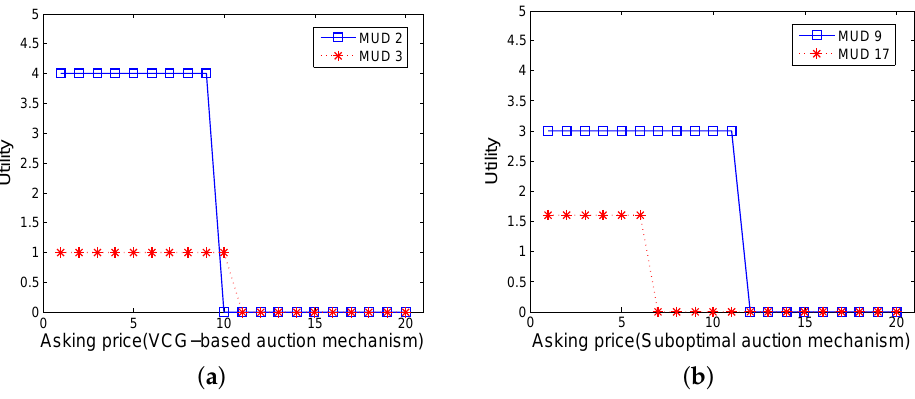
Figure 5. ( a ) The utility of MUD 2 and MUD 3 by VCG-based auction mechanism in continuous working case; ( b ) The utility of MUD 9 and MUD 17 by suboptimal auction mechanism in continuous working case.